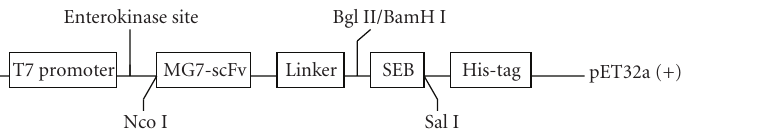
Figure 1: The schematic diagram of plasmid pET32a(+)/MG7-scFv/SEB. Enterokinase site: DDDDK; the linker: (Gly 4 Ser) 3 ; His-Tag: six- histidine amino acid tag.